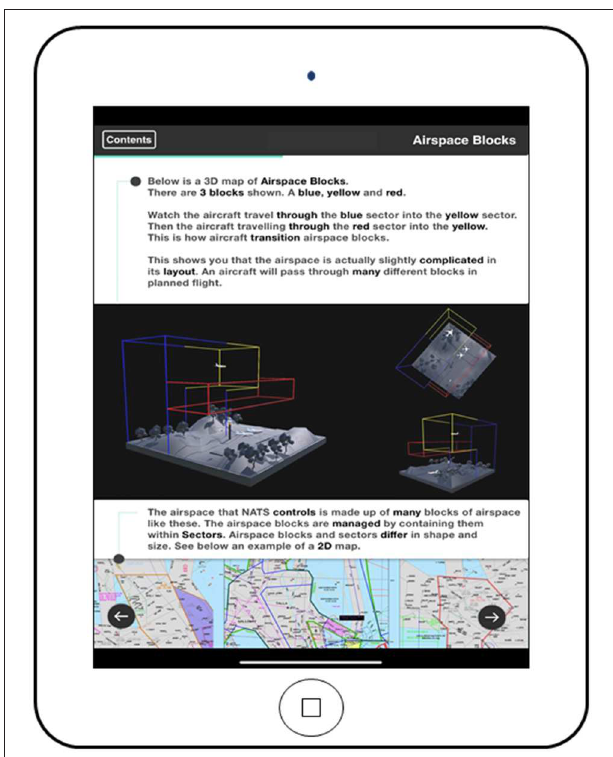
FIGURE 9 | “Airspace Blocks” screen of the ACPO starter